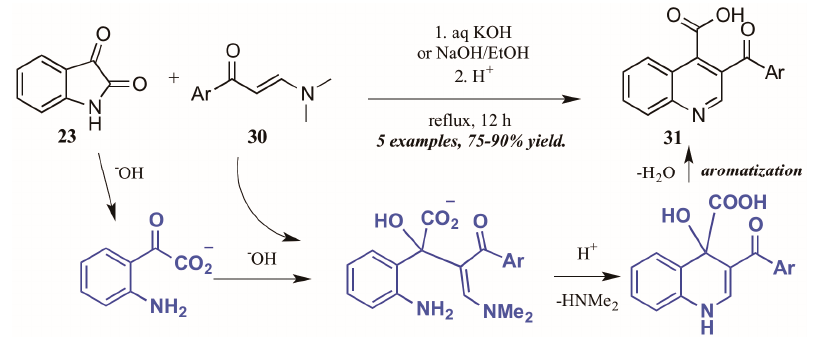
Figure 15. Pfitzinger reaction using enaminones under basic conditions.